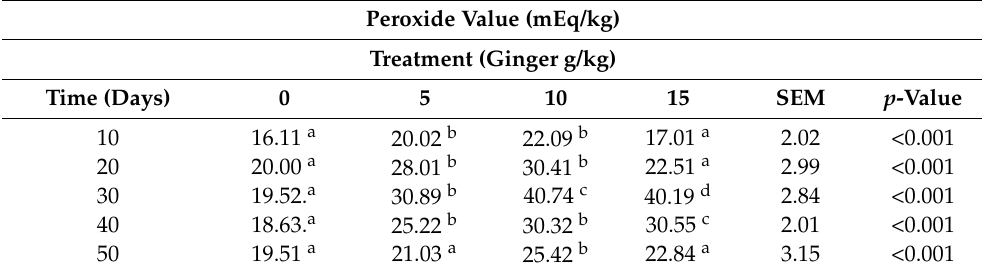
Table 5. Peroxide value (PV) of lipid extracted from stored ginger-supplemented dietary feed rations over 50 days of oxidation.